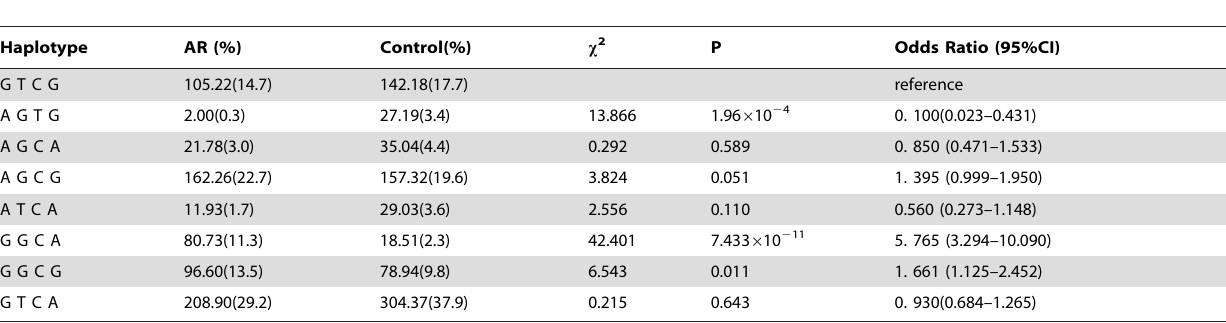
Table 4. Frequencies of the haplotypes formed by rs17375018, rs7517847, rs1343151 and rs11209032 SNPs in AR patients and healthy control